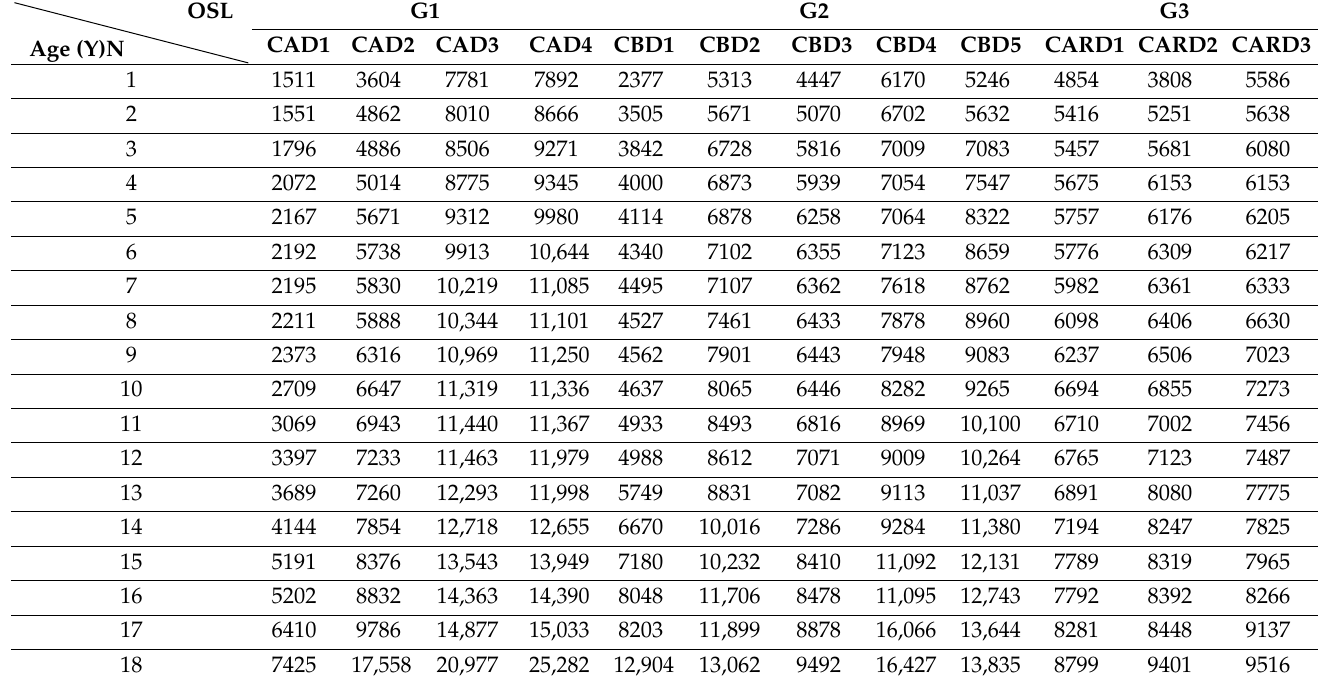
Table 8. Individual OSL ages (y).